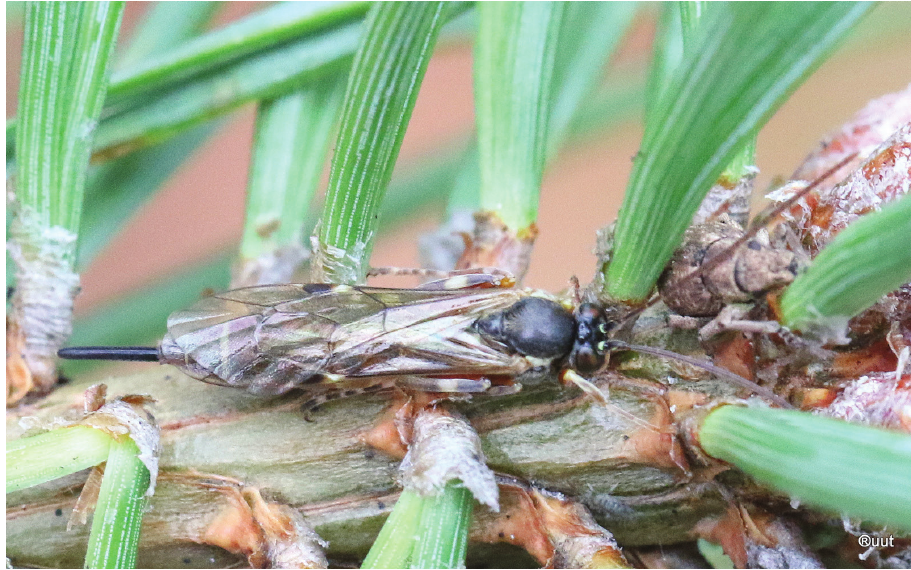
Figure 3. A female of Itoplectis maculator (Fabricius, 1775) found in hibernation position on Pinus sylves- tris L. in the Netherlands, Eindhoven (Stratumse Heide), 12 November 2020. Ruut Aussems.